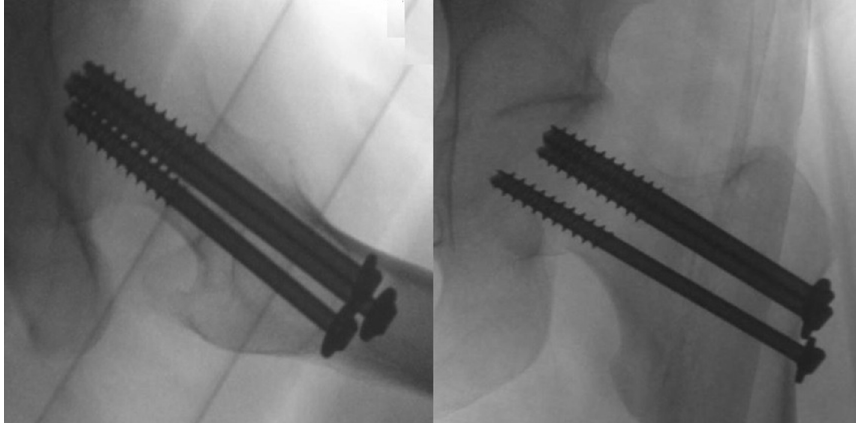
Figure 3. Intraoperative fl uoroscopy demonstrate adequate reduction and position of the cannulated screws.